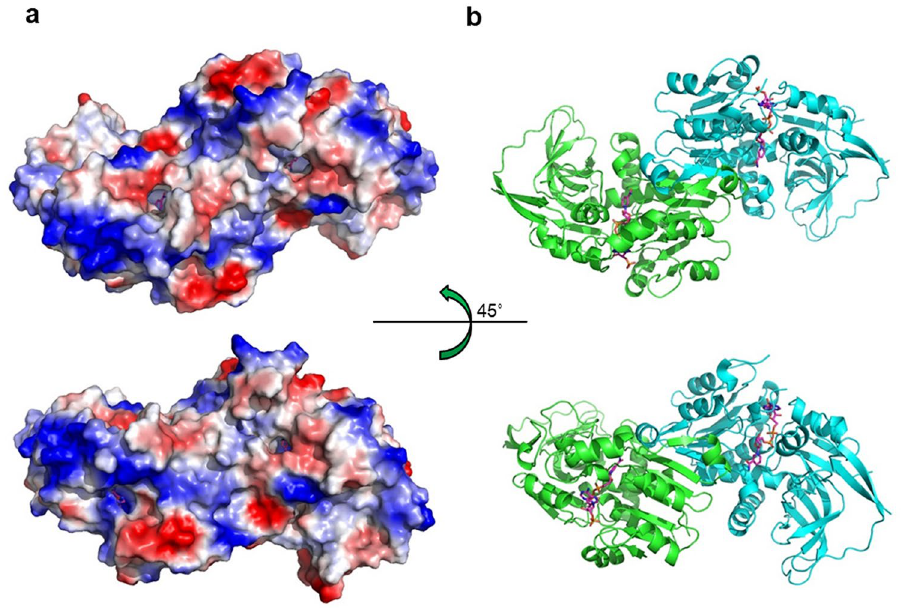
Figure 8. Molecular surface of VAT-1. ( a ) Electrostatic potential surface of the VAT-1 dimer. ( b ) As in ( a ) but of the corresponding ribbon